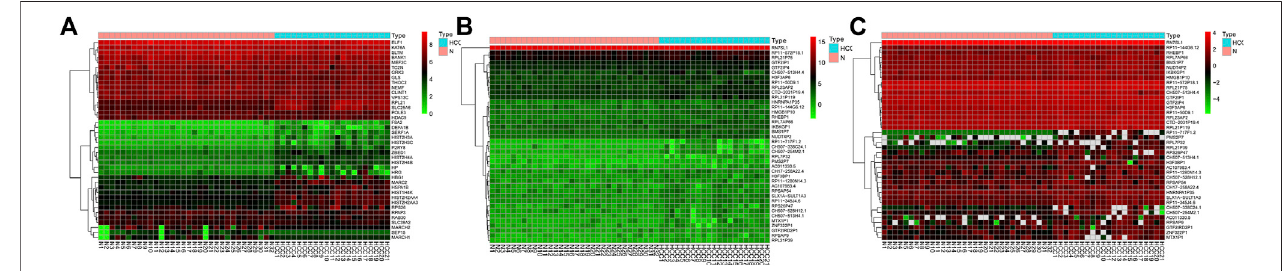
FIGURE 1 | The heatmap of top 20 upregulated and downregulated mRNAs, lncRNAs, and circRNAs. (A) mRNAs; (B) lncRNAs; (C)